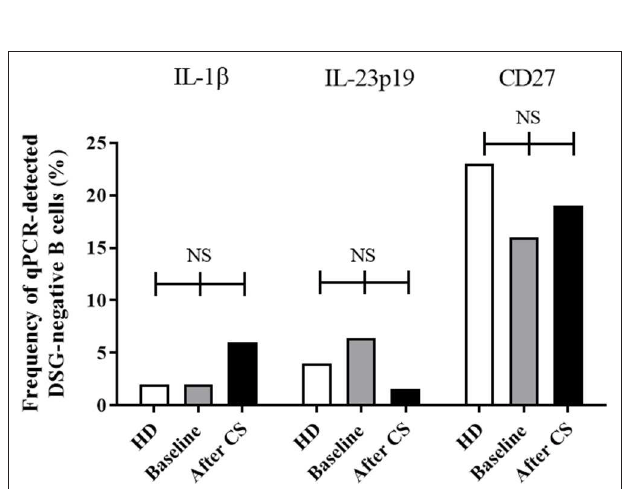
FIGURE 6 | Frequency of cells with detectable mRNA encoding for IL-1 β , IL-23p19, and CD27 in one-cell sorted desmoglein-negative B cells from healthy donors (white columns, n = 69 cells), and pemphigus patients at baseline before treatment (gray columns, n = 201 cells) or after corticosteroids treatment (black columns, n = 123 cells). Frequencies were compared using the Fisher’s exact test.